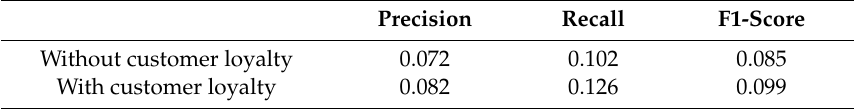
Table 6. Recommendation e ff ect of DeepWalk with and without customer